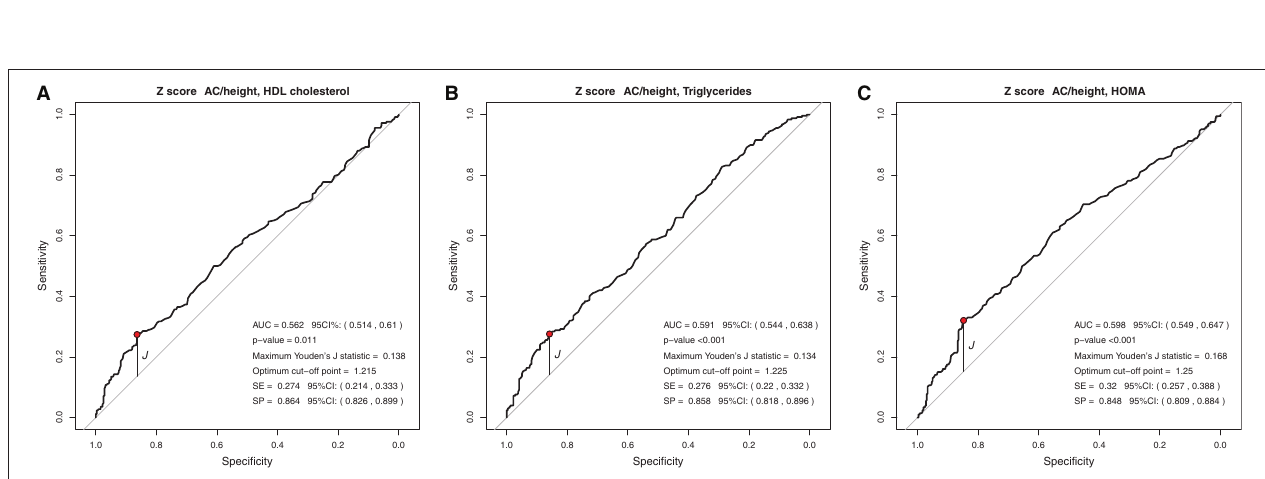
Frontiers in Nutrition | www.frontiersin.org